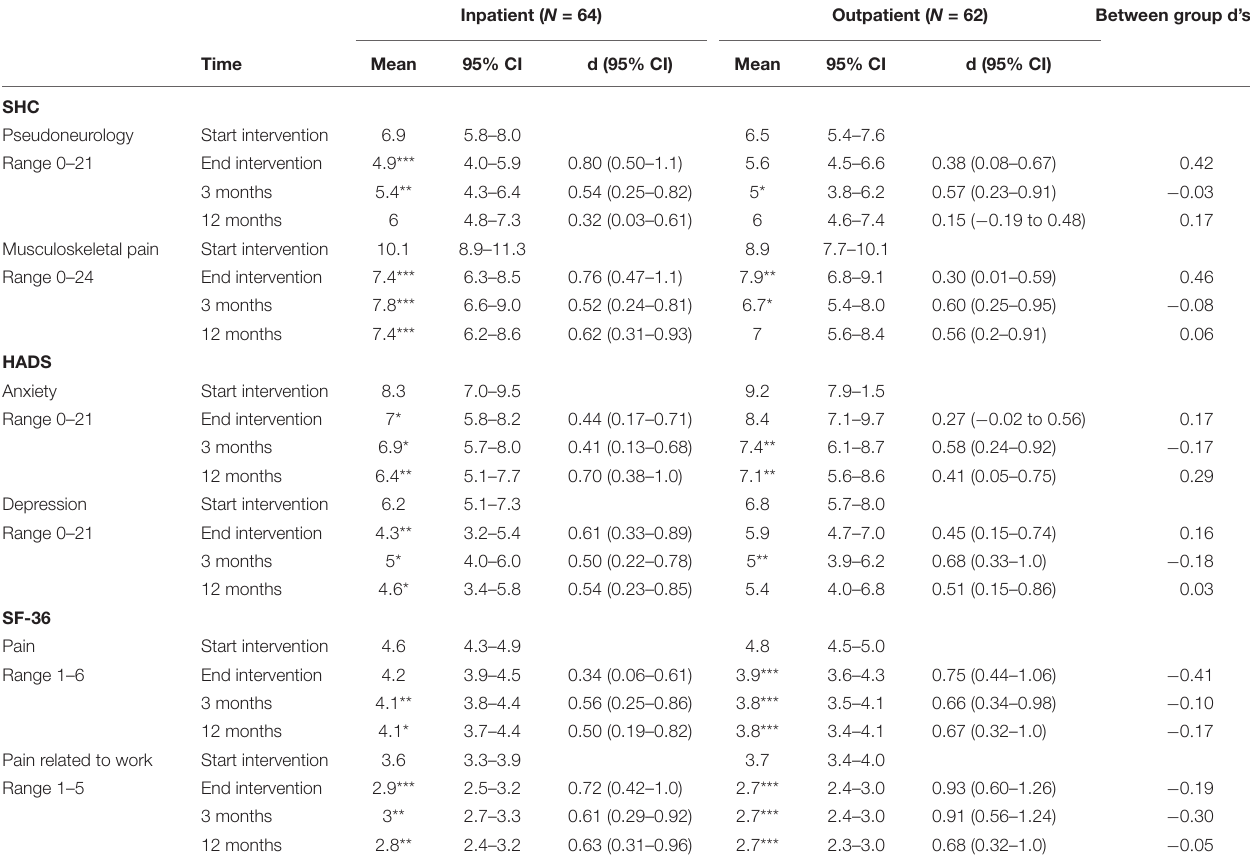
TABLE 2 | Health-related outcomes: pre- and post-test scores (M, CI), within-group effect sizes (Cohen’s d with CI), and between-group effect sizes (Cohen’s d). Inpatient ( N = 64) Outpatient ( N = 62) Between group